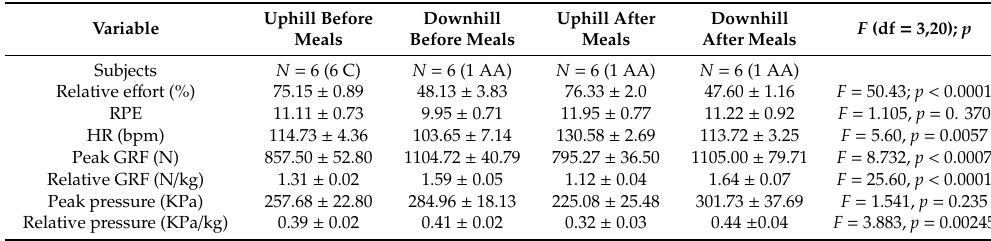
Table 2. Exercise parameter